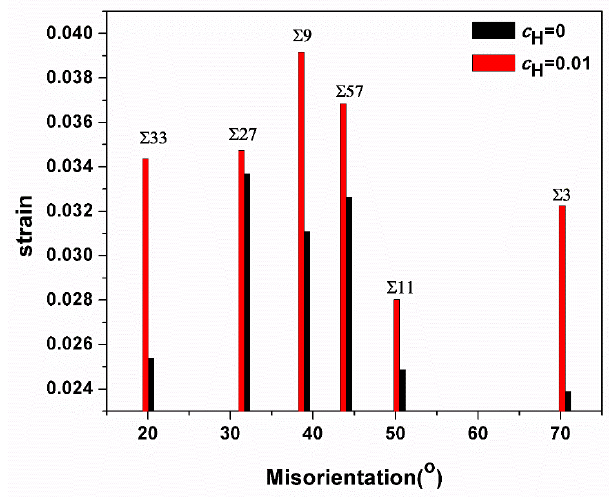
Figure 11. Comparison of the strain values at which first dislocations are emitted from the GBs.